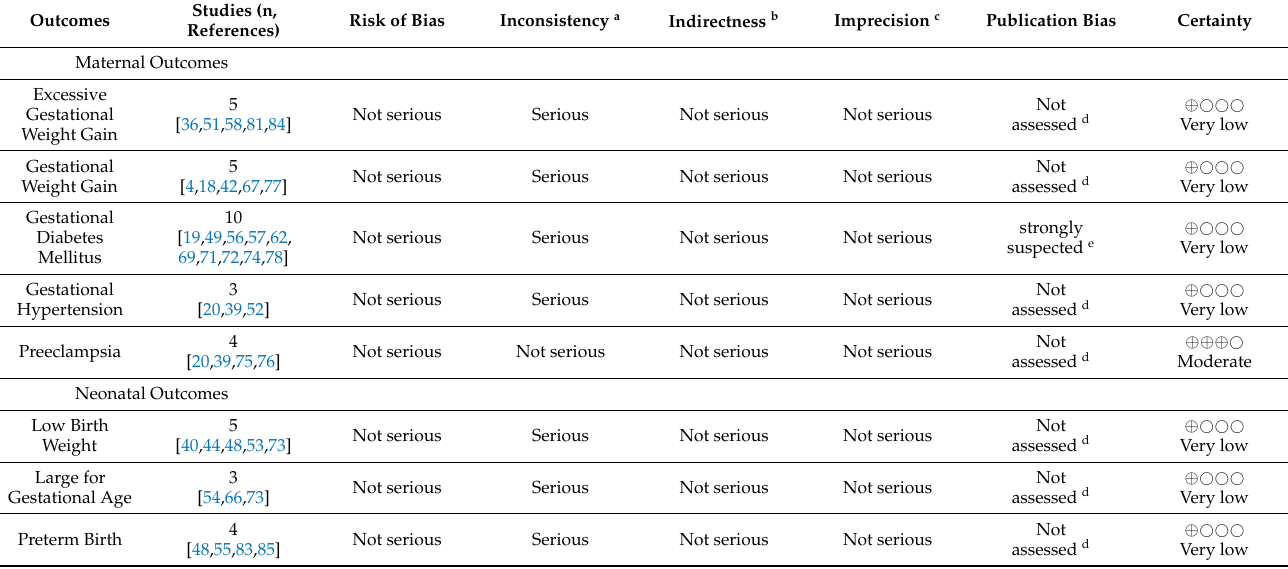
Table 2. GRADE evidence profile for maternal UPF consumption and perinatal